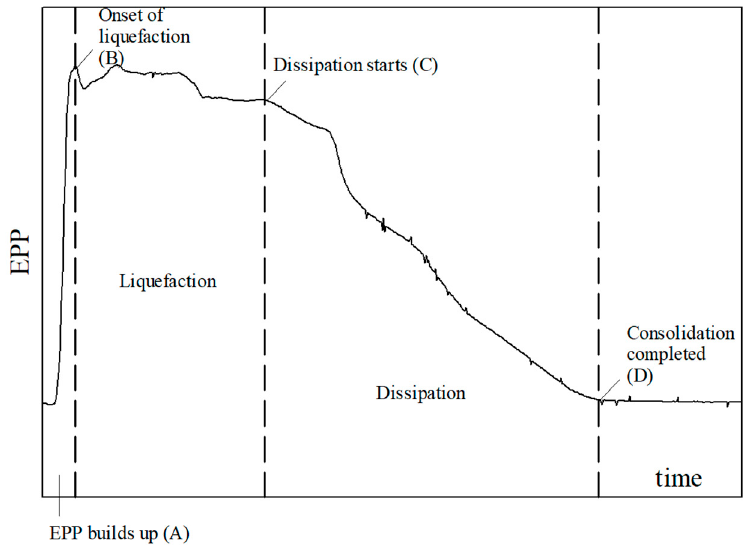
Figure 6. Schematic variation of period-averaged pore-water pressure at depth z.